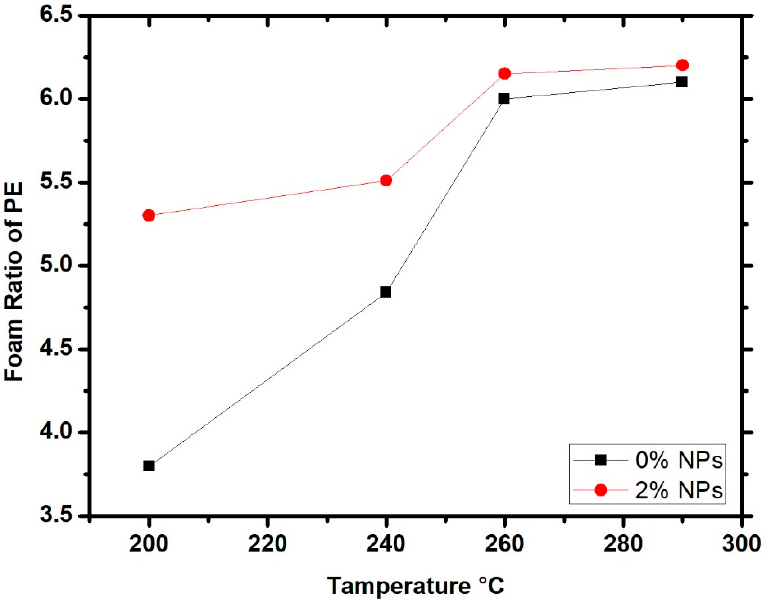
Figure 7. Foam ratios as a function of temperature for pure CC and CC + 2% NPs.